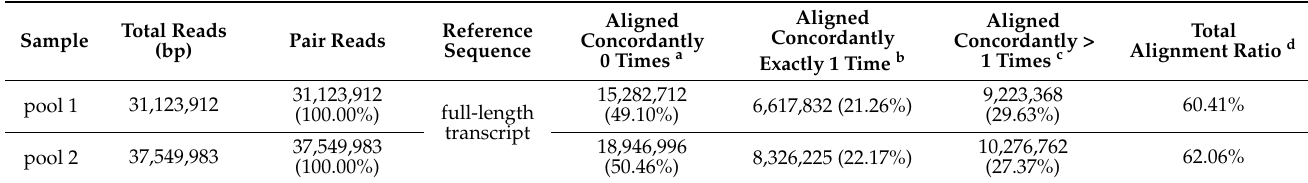
Table 1. Alignment results of two bulk reads on full-length